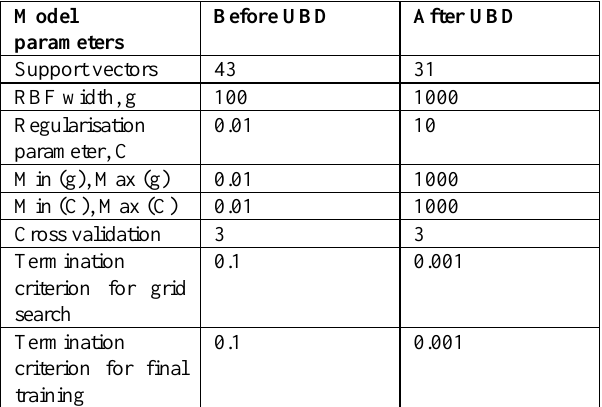
Figure 1. Workflow of the herein processed methodology. The Planet Image Time Series consists of three different PlanetScope Analytic Ortho Scenes. Lyzenga’s empirical water column correction is adapted from Lyzenga (1978, 1981).